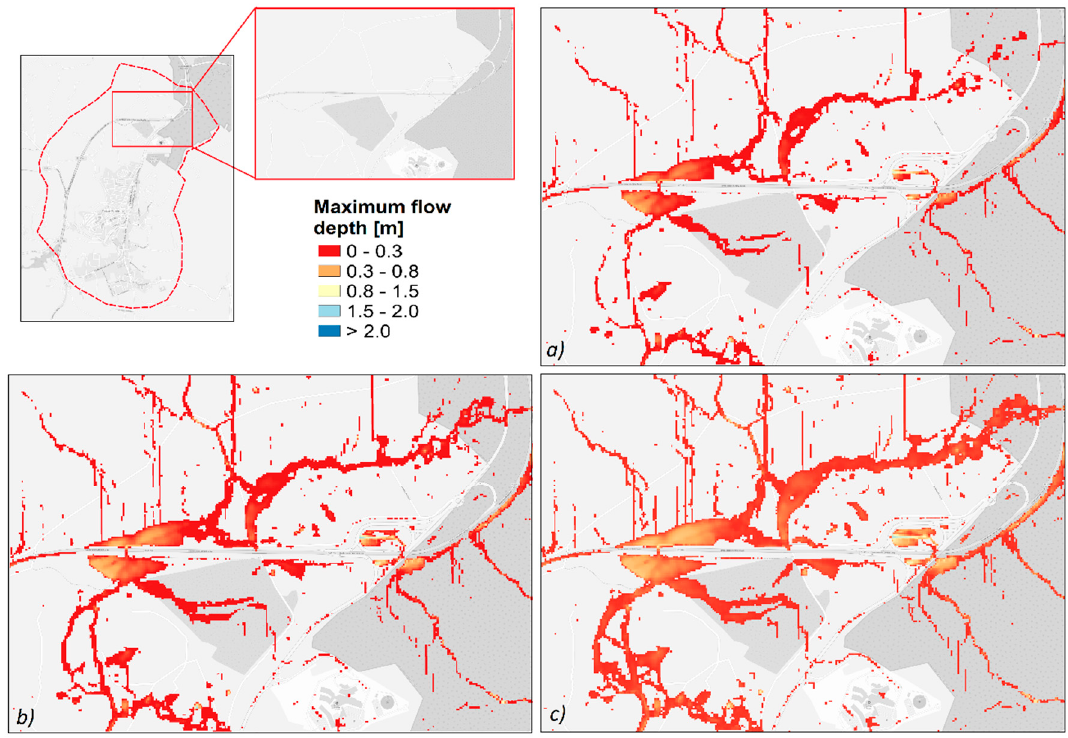
Figure 7. Detail of a flooded urban area in Piazza Armerina for T = 20 years: ( a ) 2010 scenario; ( b ) 2025 scenario; and ( c ) 2050 scenario.